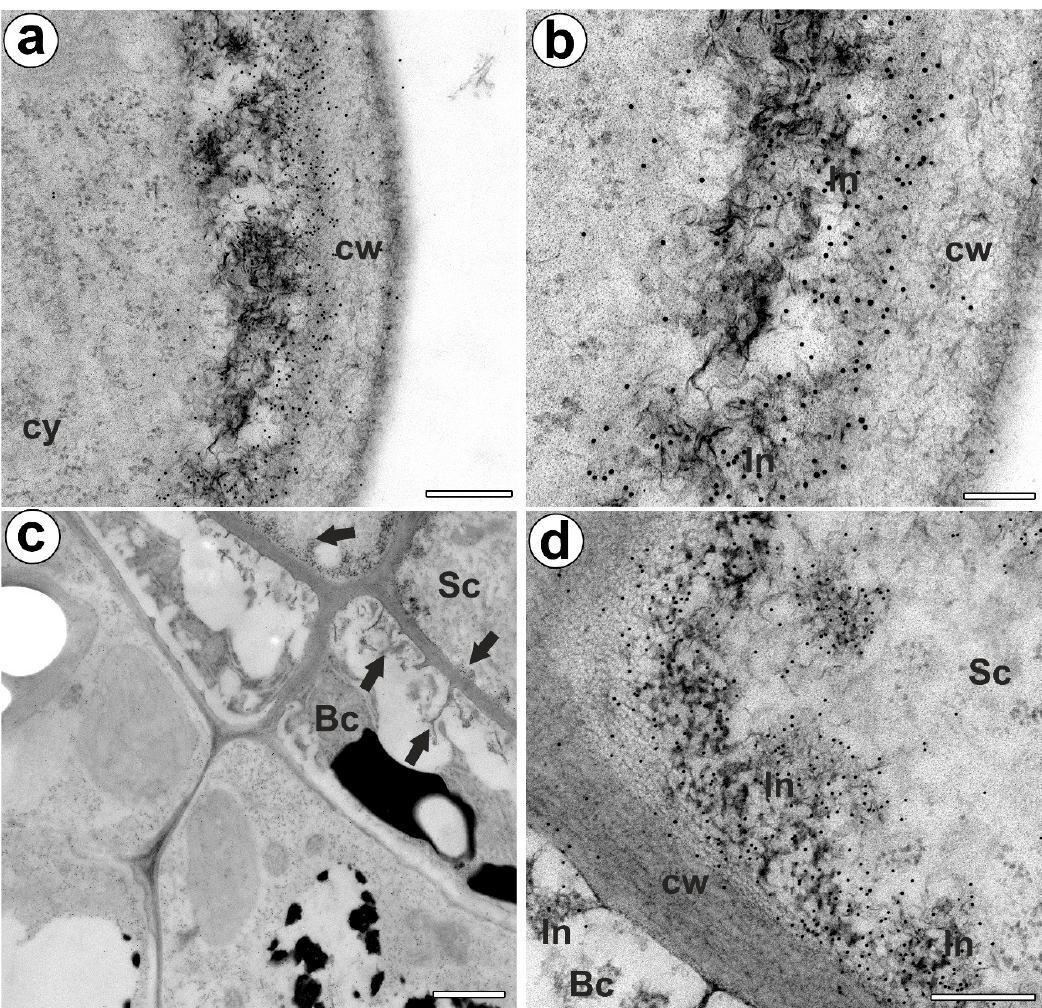
Figure 3. Arabinogalactan proteins (labeled with JIM13) detected in the bifid trichomes of the Aldrovanda vesiculosa traps. ( a , b ) Immunogold labeling of wall ingrowths with JIM13 in head cell; cytoplasm (cy), cell wall (cw), cell wall ingrowth (In), bar 300 nm, and bar 100 nm. ( c ) Immunogold labeling of cell walls with JIM13 in stalk (Sc) and basal cells (Bc), cell wall ingrowths (arrows), bar 1000 nm. ( d ) Immunogold labeling of cell wall ingrowths with JIM13 in stalk and basal cells; stalk cell (Sc), basal cell (Bc) cell wall ingrowth (In), bar 300 nm.